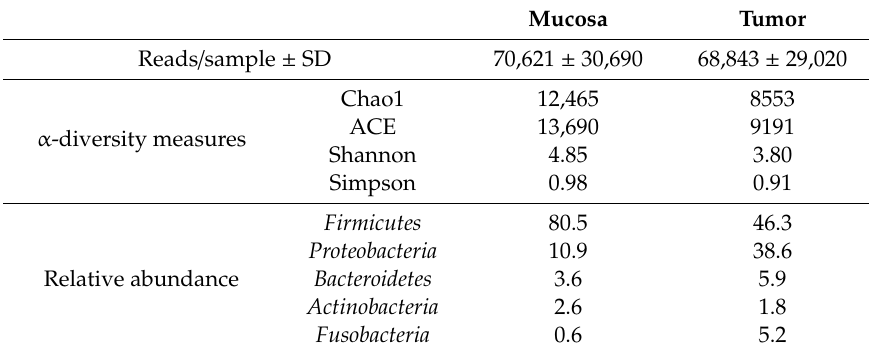
Table 4. Amount of high-quality reads and α -diversity measures as well as relative abundance for most abundant species on phylum level (%) of tumor and normal mucosa tissue samples in Step 2